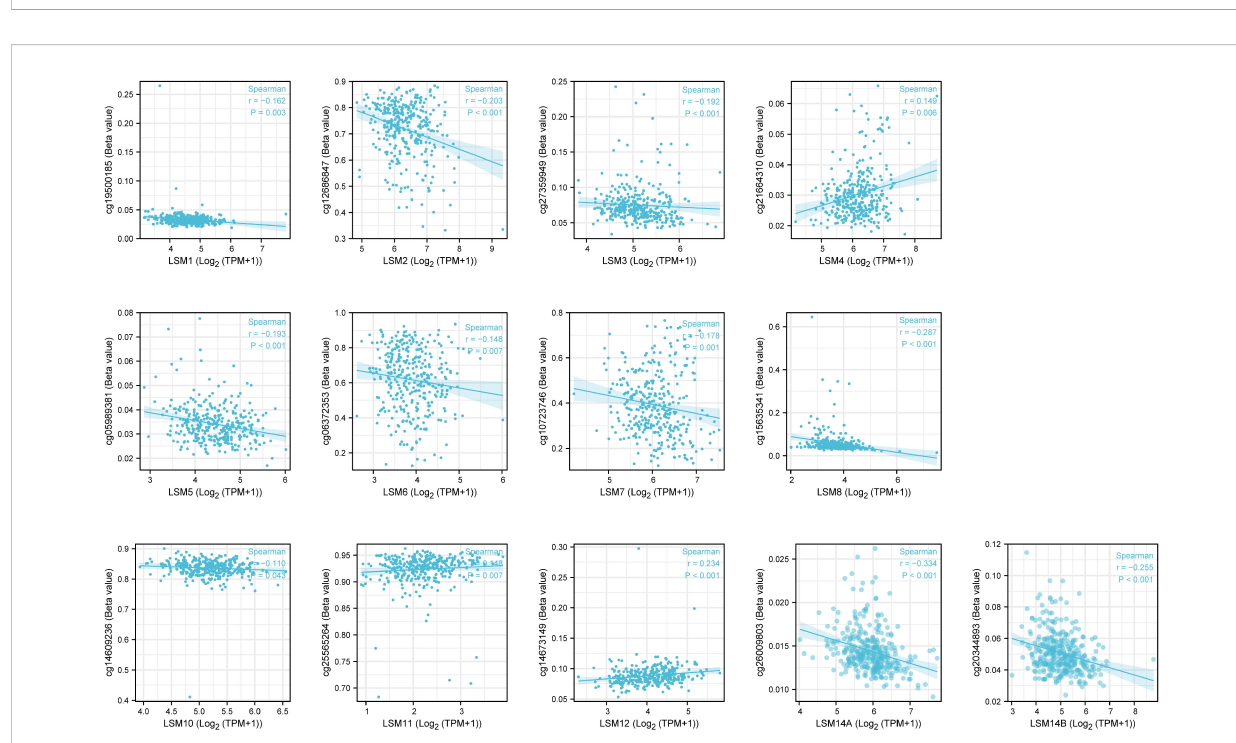
FIGURE 3 The DNA methylation level of LSM family members in GC by Methsurv analysis. From TCGA RNAseq data in level 3 HTSeq-FPKM format and ilumina human methylation 450 methylation data in STAD (gastric cancer)